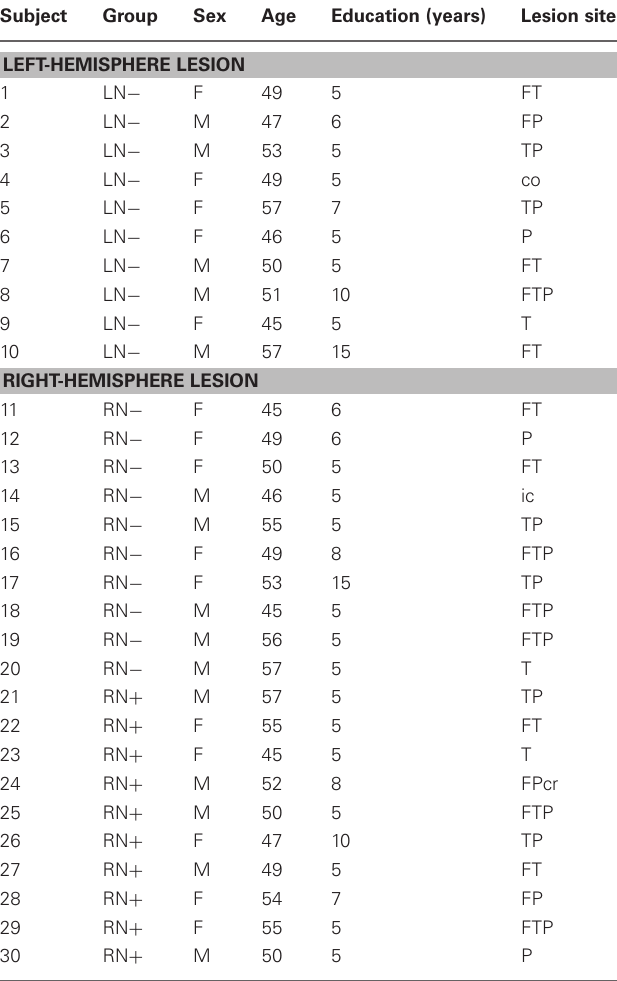
Table 1 | Personal data and lesion site of